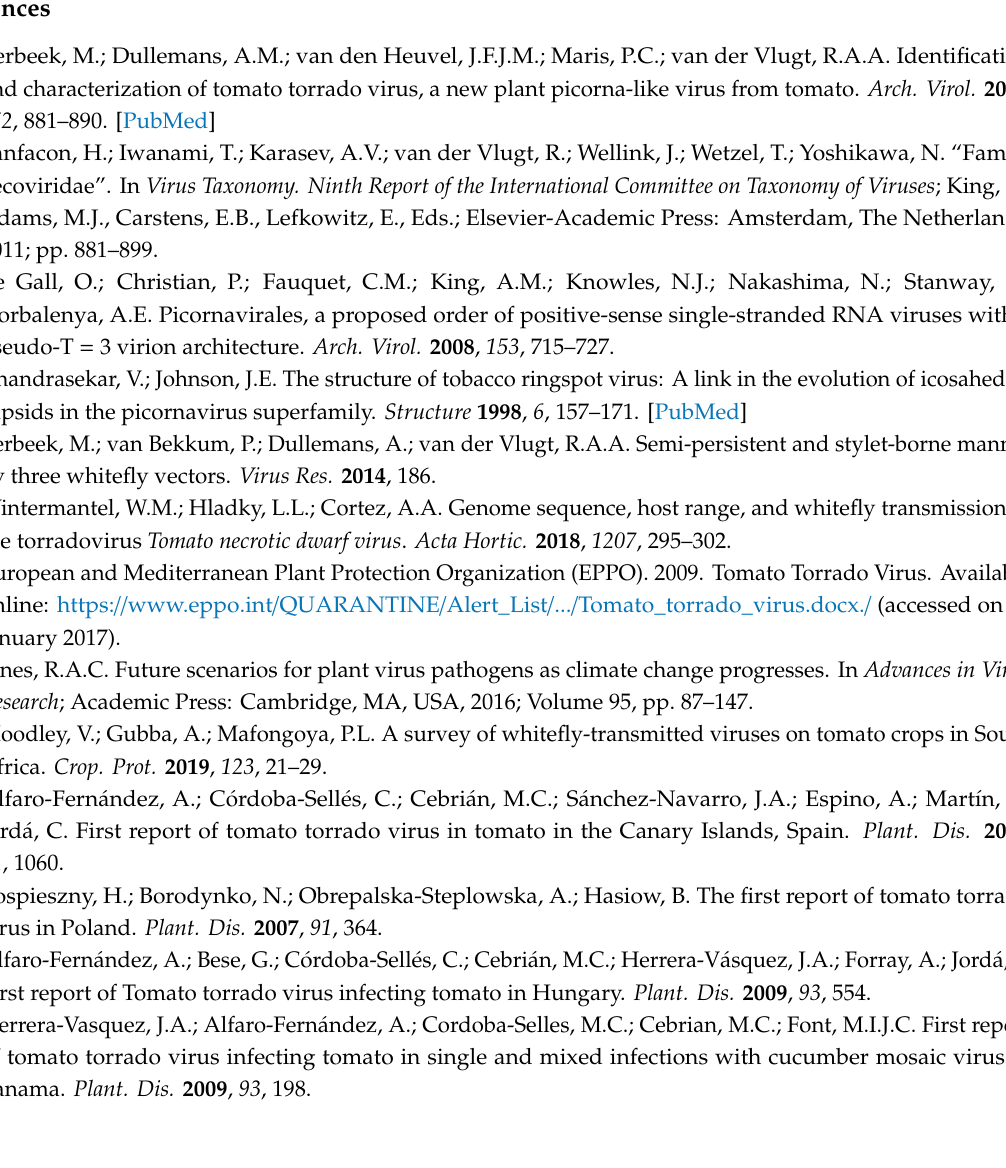
Table S1: Primers used to reconstruct the RNA-1 segment of an isolate of ToTV infecting tomato crops in South Africa., Table S2: Primers used to reconstruct the RNA-2 segment of an isolate of ToTV infecting tomato crops in South